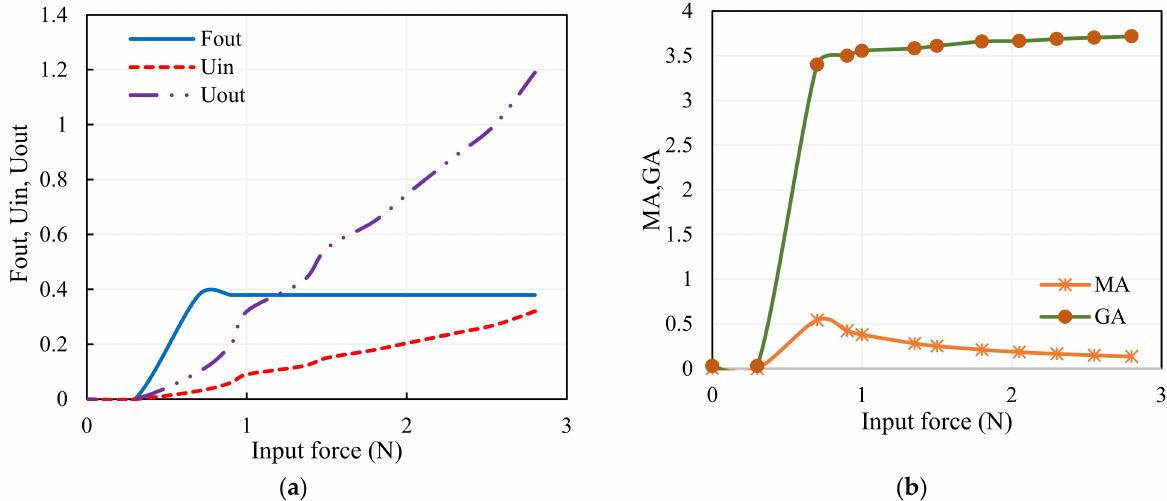
Figure 8. Mechanical features of the gripper: ( a ) characteristics of the SMA-actuated compliant gripper, ( b ) performance of the